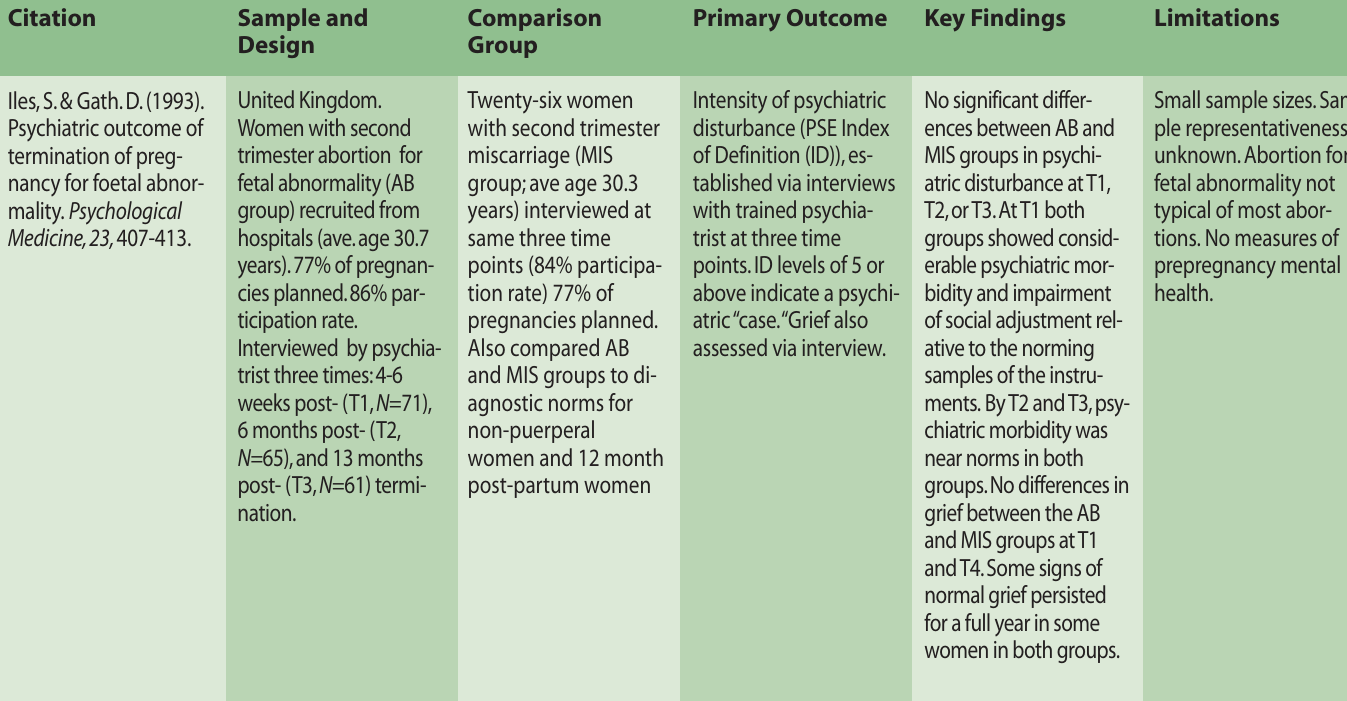
Table 4: Abortion for Reasons of Fetal Anomaly